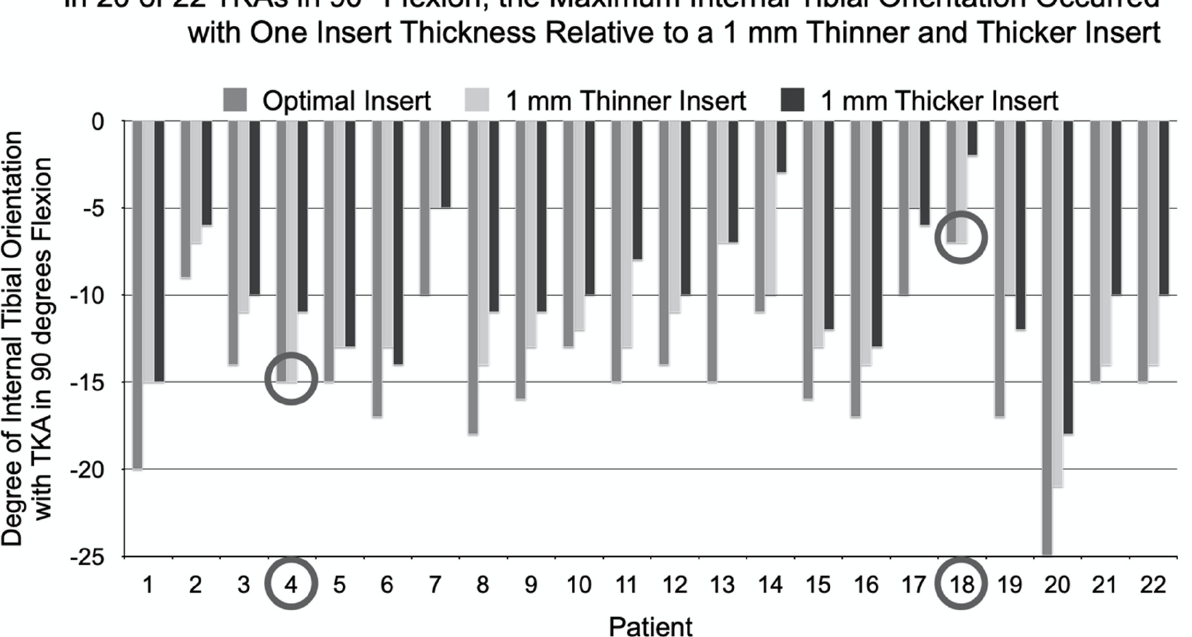
Figure 4. For each TKA at 90 ◦ flexion, the column graph shows the degree of internal tibial orientation for the optimal and 1 mm thinner and thicker inserts. The optimal insert thickness was determined in extension in two patients because two insert thicknesses had the same maximum internal orientation at 90 ◦ flexion (circled in